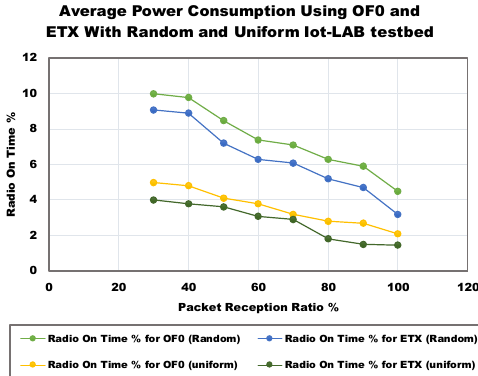
Figure 13. The average power consumption for OF0 and ETX with uniform and random topologies.